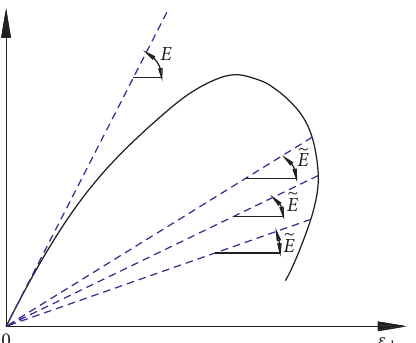
Figure 7: The schematic diagram of dynamic stress-strain curves with one-dimensional dimensionless.